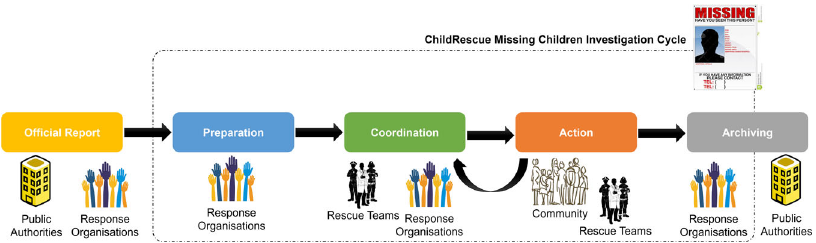
Fig. 2 A new missing children investigation cycle, structured in four (4) phases — preparation, coordination, action, and archiving — that follow the of fi cial report of the disappearance. The engaged stakeholders on each phase are also